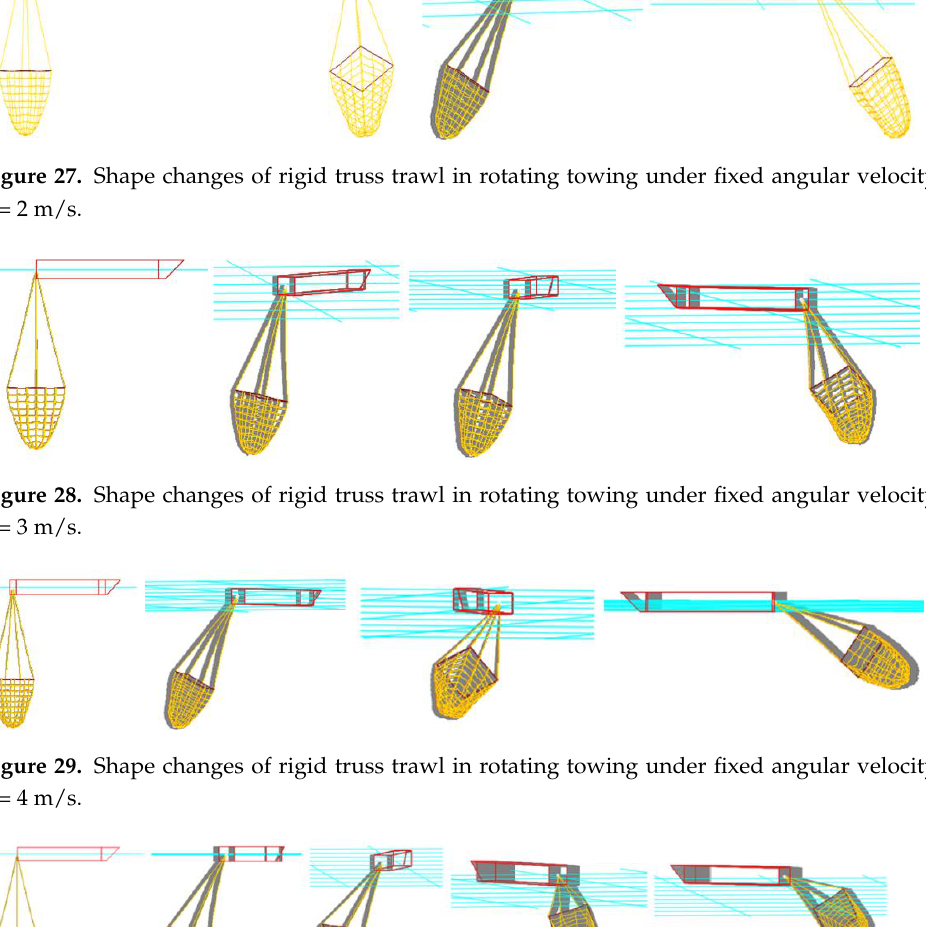
Figure 30. Shape changes of rigid truss trawl in rotating towing under fixed angular velocity at v =